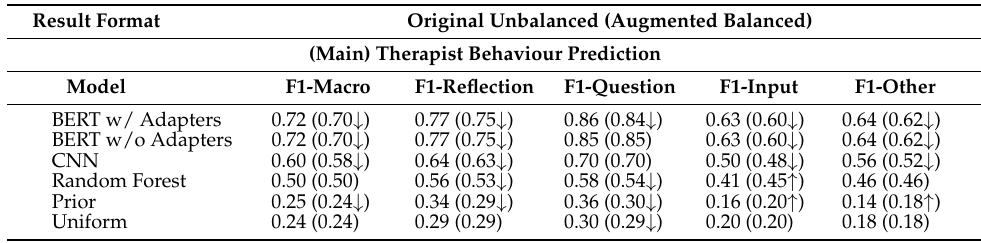
Table 15. Macro F1 and per-class F1 scores of (main) therapist behaviour prediction. All results averaged from 5-fold cross-validation. ↑ / ↓ : performance increase/decrease by using Augmented Balanced compared to using Original Unbalanced.